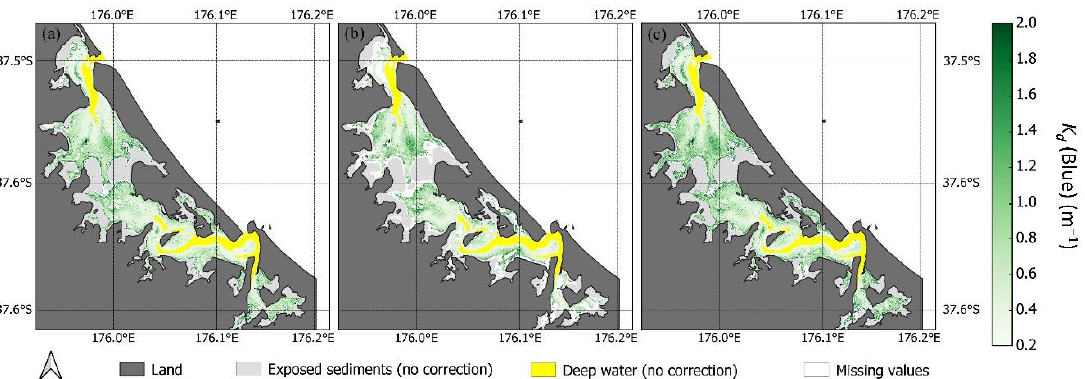
Figure A1. Examples of K d maps derived from images from the same month with similar conditions (( a ) 1 January 2021, ( b ) 31 January 2021, ( c ) 20 February 2021). Reflectance in emerged (exposed sediment) regions and optically deep channels did not need correction, which are marked in grey and yellow, respectively. The missing values due to nonuniform input data are marked in white.